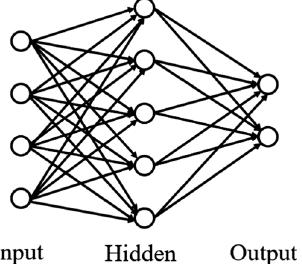
FIG. 1. A schematic of a typical fully connected neural